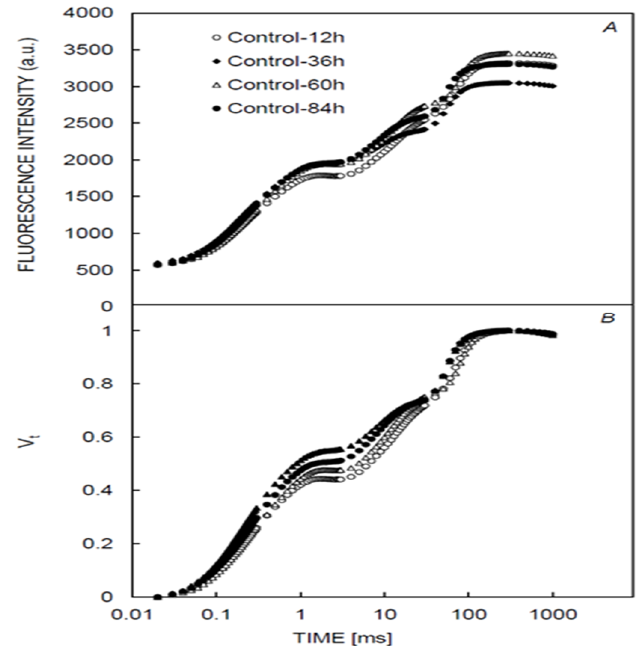
Figure 1. Chlorophyll a fluorescence from control. Samples which showed the typical polyphasic fluorescence (OJIP) curve at different time intervals ( A ) were plotted as fluorescence intensity, whereas ( B ) was plotted as relative variable fluorescence, Vt.